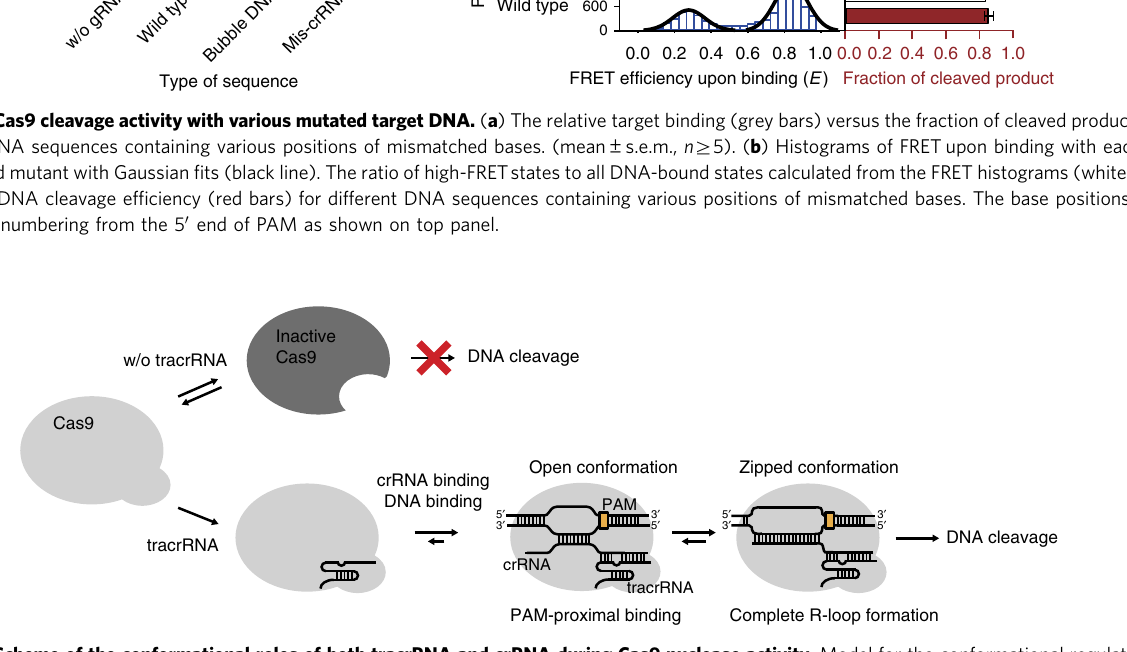
Figure 5 | Scheme of the conformational roles of both tracrRNA and crRNA during Cas9 nuclease activity. Model for the conformational regulation of gRNAs during target DNA binding and cleavage process by Cas9:gRNA